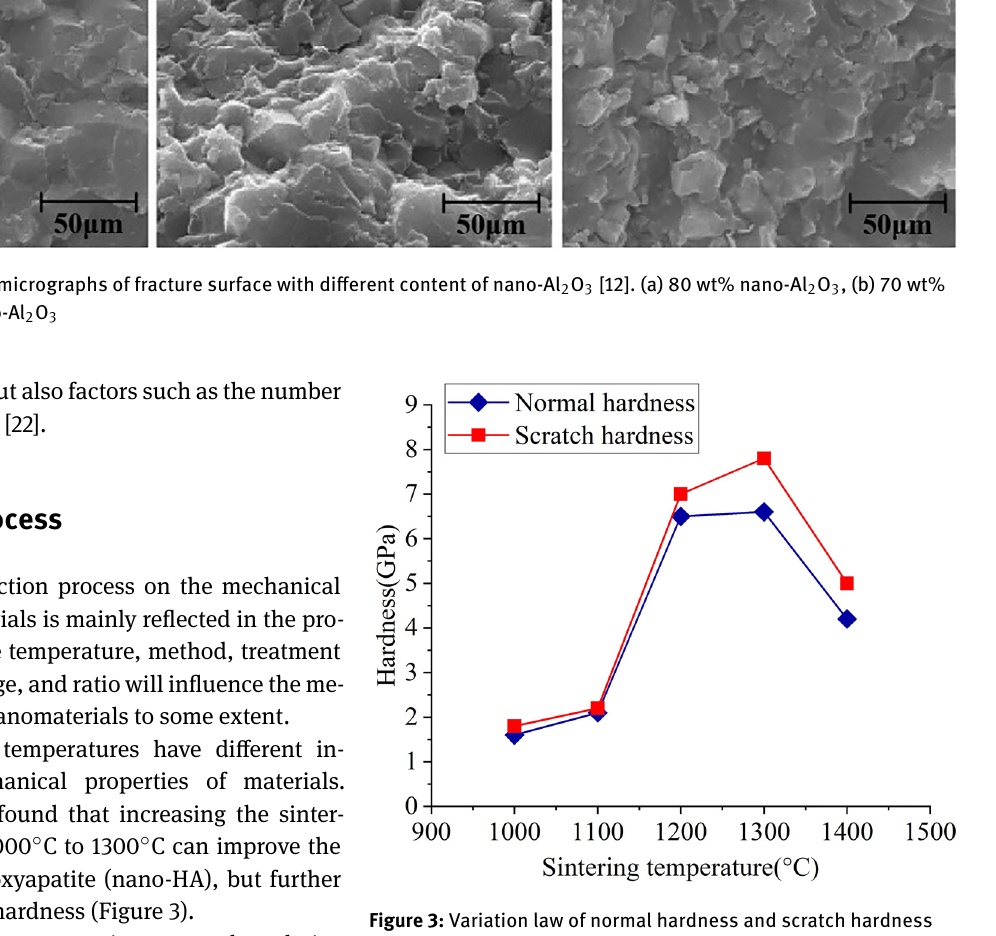
Figure 3: Variation law of normal hardness and scratch